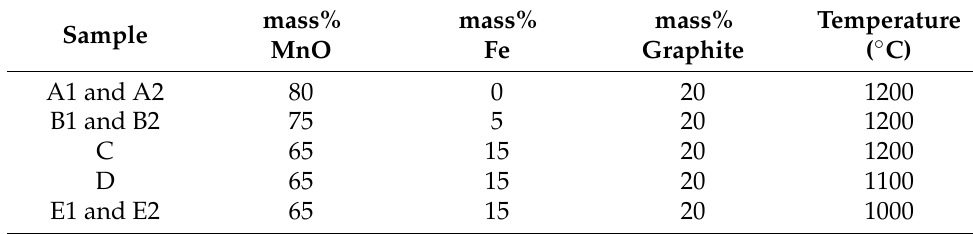
Table 1. Experimental conditions: MnO-Fe-graphite samples.